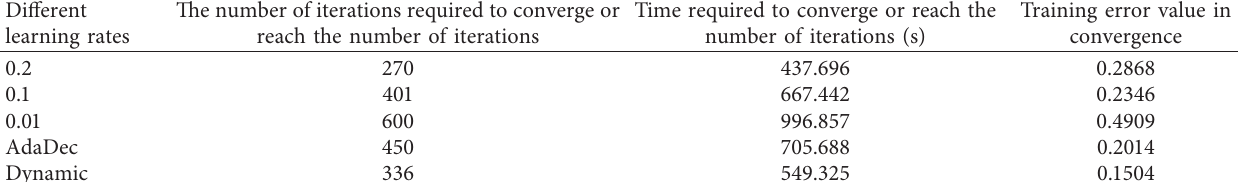
Table 3: The results of different learning rates.